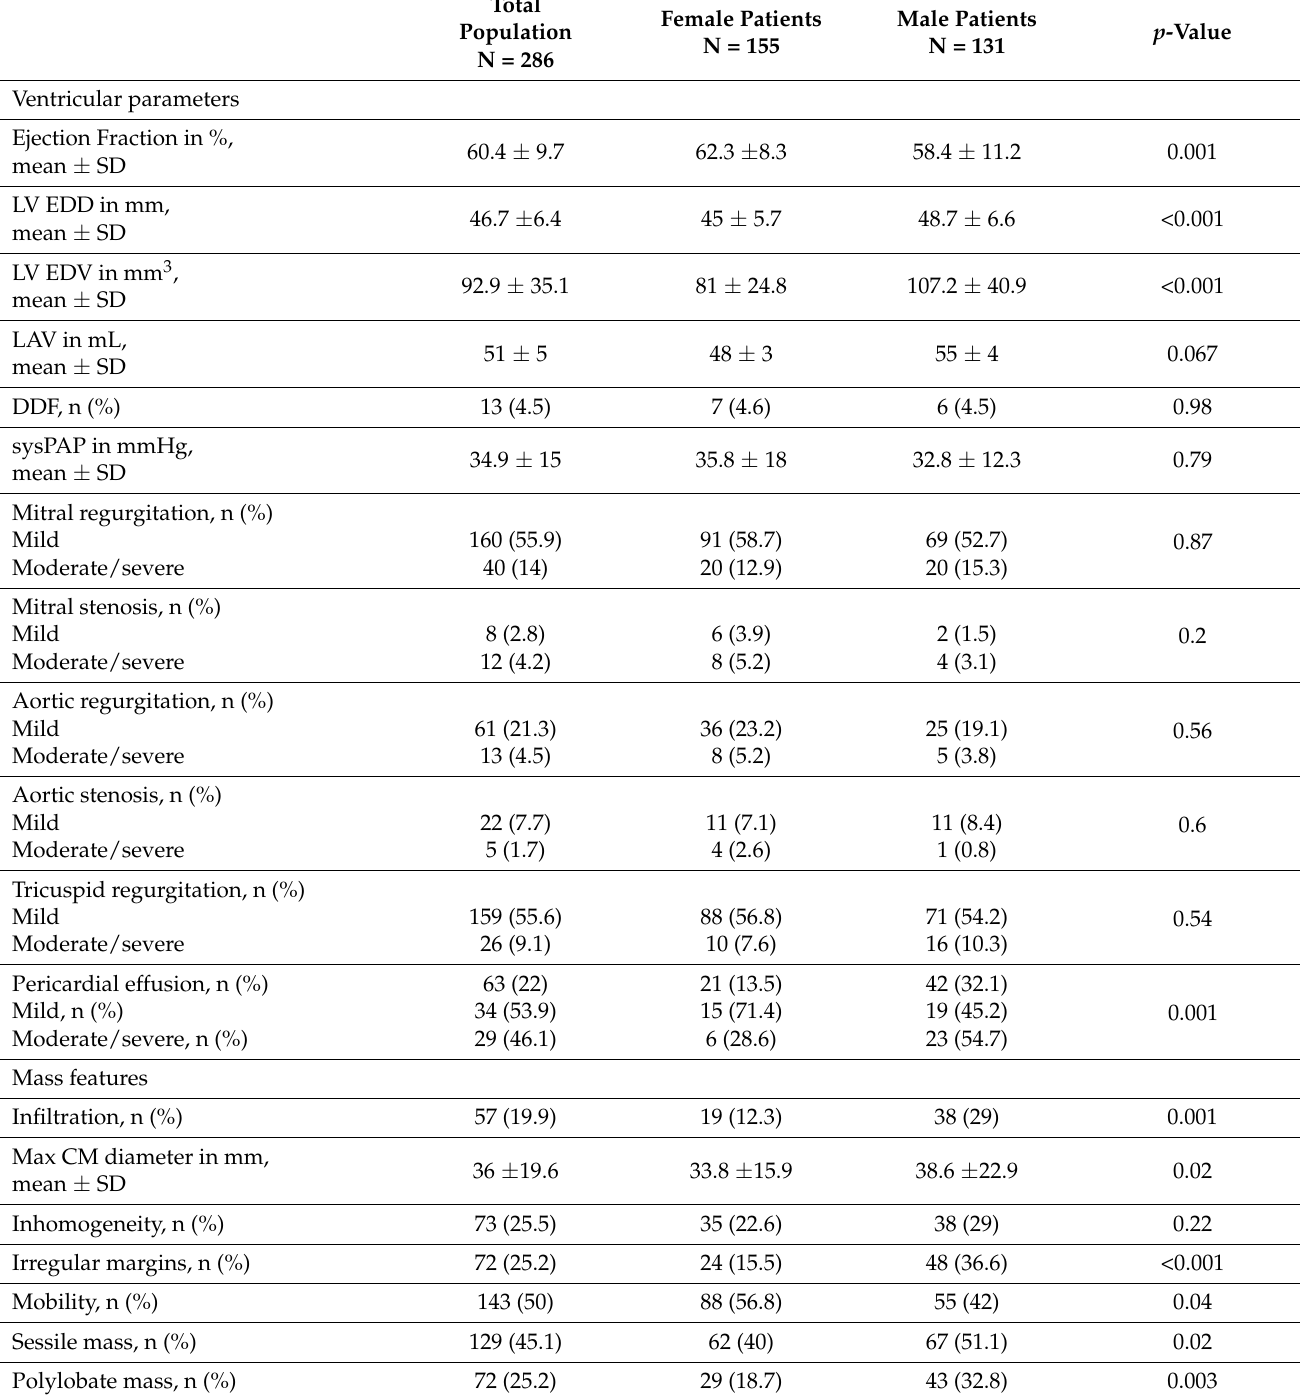
Table 4. Comparison of echocardiographic features between male and female patients affected by cardiac neoformations. Total Female Population N = 286